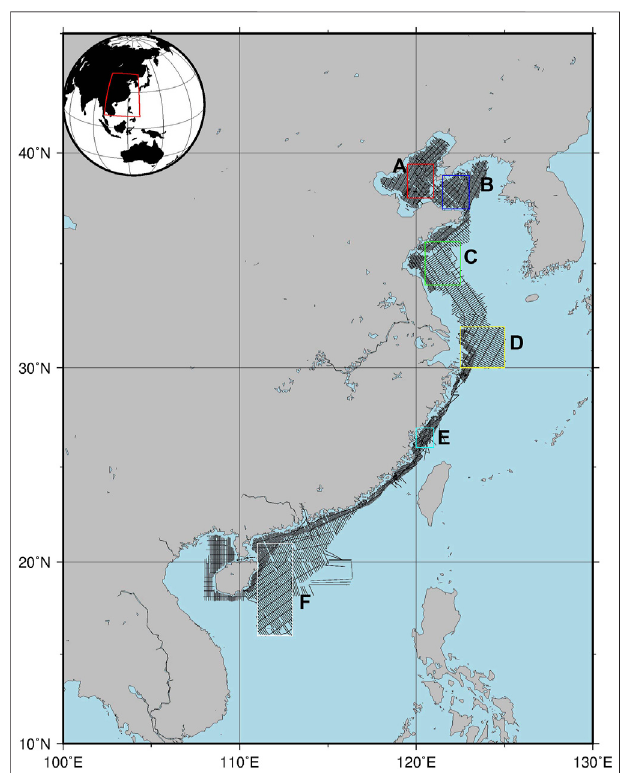
FIGURE 3 | Geographic distribution ofshipboard gravity measurements from the 908 Project in the coastal regions of China. Areas A – F in different colors are selected to demonstrate the accuracies of marine gravity models in different